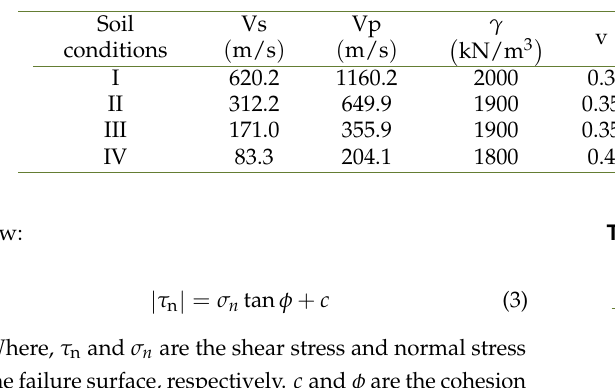
Table 3. Parameters of site soil